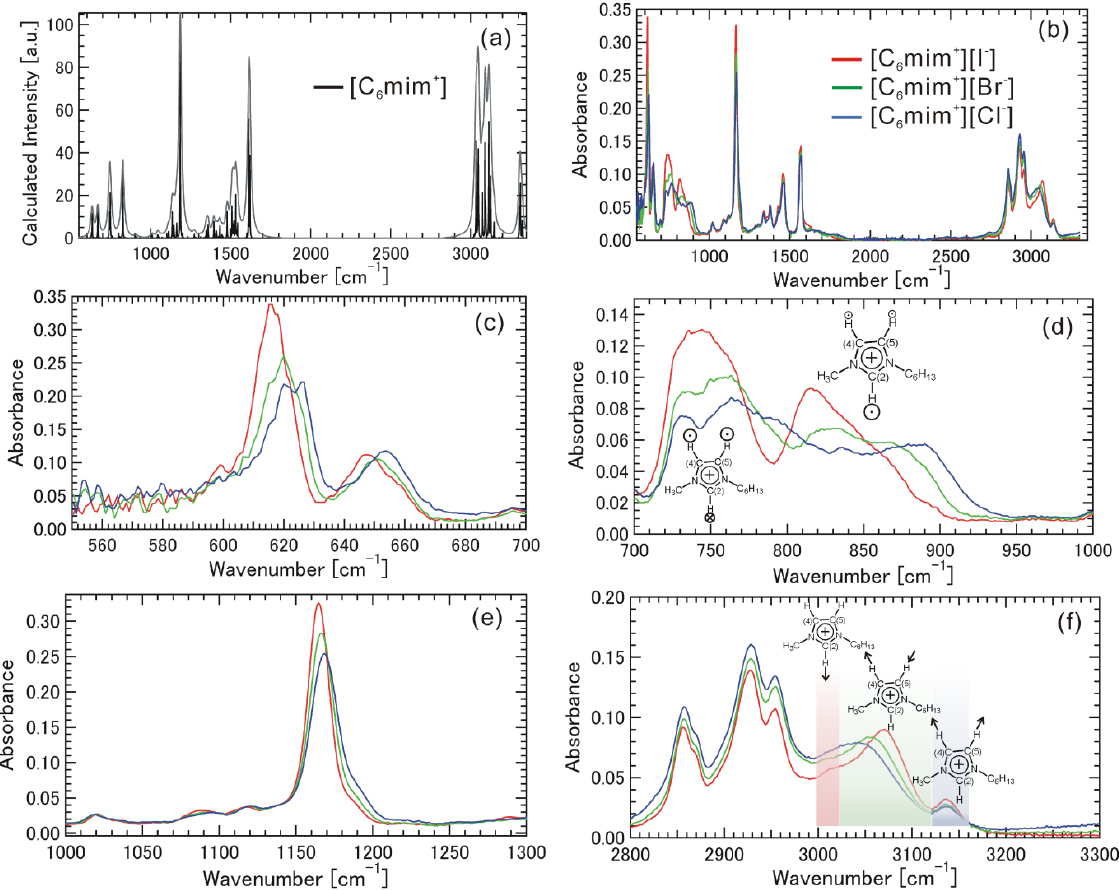
Figure 6. Calculated IR spectrum of [C 6 mim + ] ( a ) from 550 to 3300 cm −1 , and experimental IR spectra of [C 6 mim + ][I − ], [C 6 mim + ][Br − ], and [C 6 mim + ][Cl − ]; ( b ) from 550 to 3300 cm −1 ; ( c ) from 550 to 700 cm −1 ; ( d ) from 700 to 1000 cm −1 ; ( e ) from 1000 to 1300 cm −1 ; and ( f ) from 2800 to 3300 cm −1 . In ( d ), two skeletal vibrations due to the main motions of “H”s in C(2)–H, C(4)–H and C(5)–H perpendicular to the imidazolium ring plane